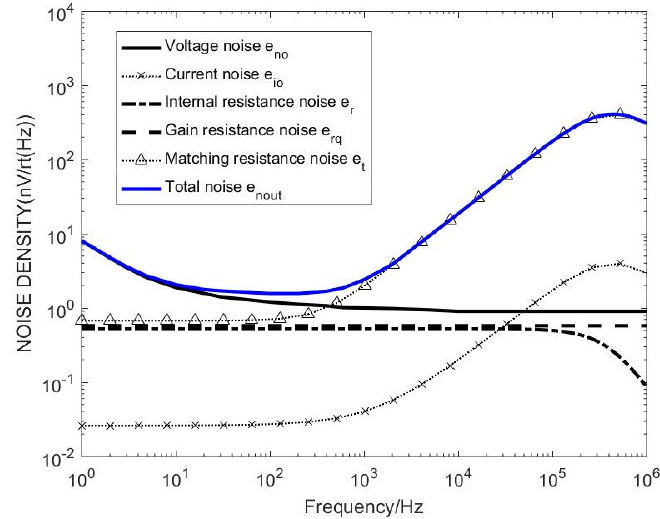
Figure 7. Noise distribution map with matching resistance sensor.